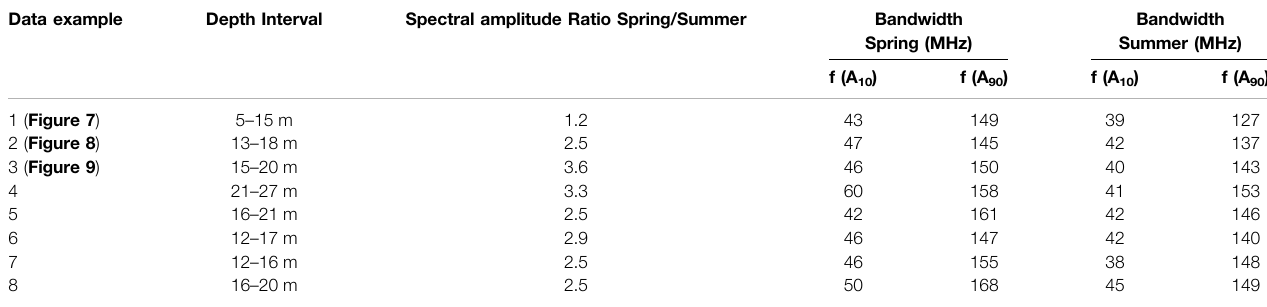
TABLE1| Evaluationofamplitudespectra:amplituderatioofspringtosummerdataandbandwidth(de fi nedby10thpercentileA 10 and90thpercentileA 90 ).Depthintervalis estimated for the time window of spring data and assuming v = 0.17 m/ns. Data